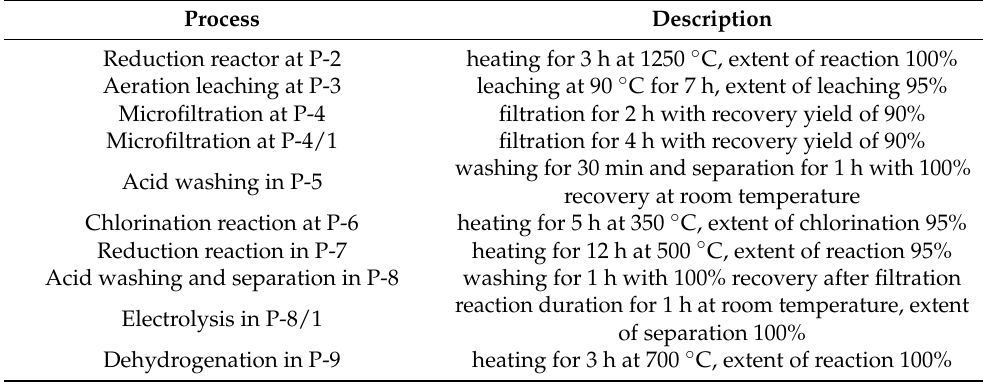
Table A2. Specifications of simulation model.